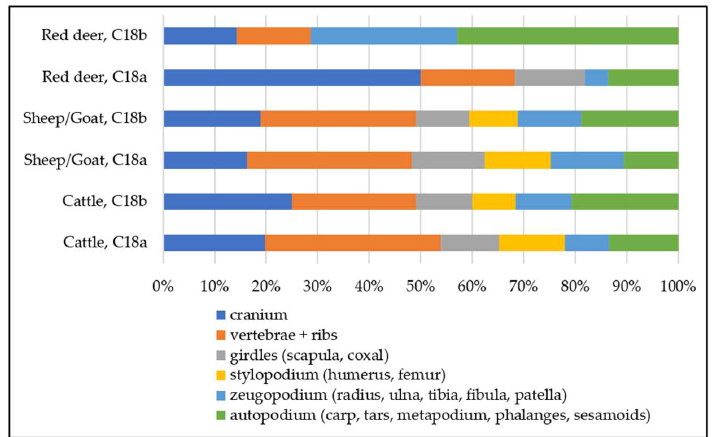
Figure 8. Distribution of cattle, sheep/goat, and red deer remains on skeletal regions.